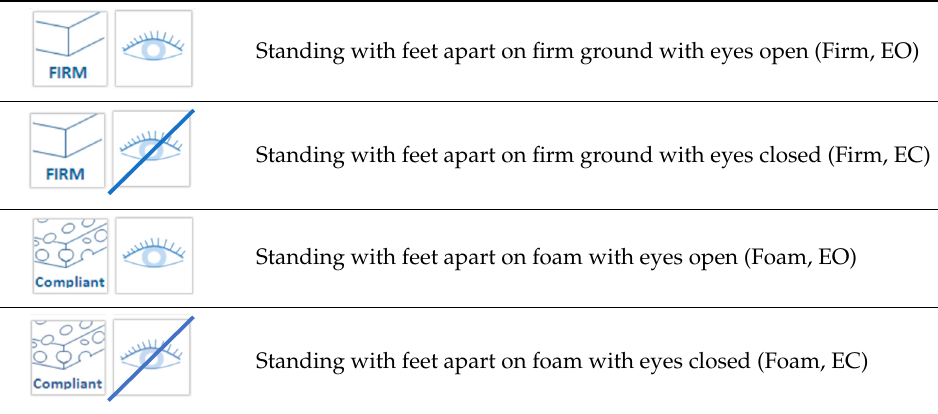
Standing with feet apart on firm ground with eyes closed (Firm, EC)